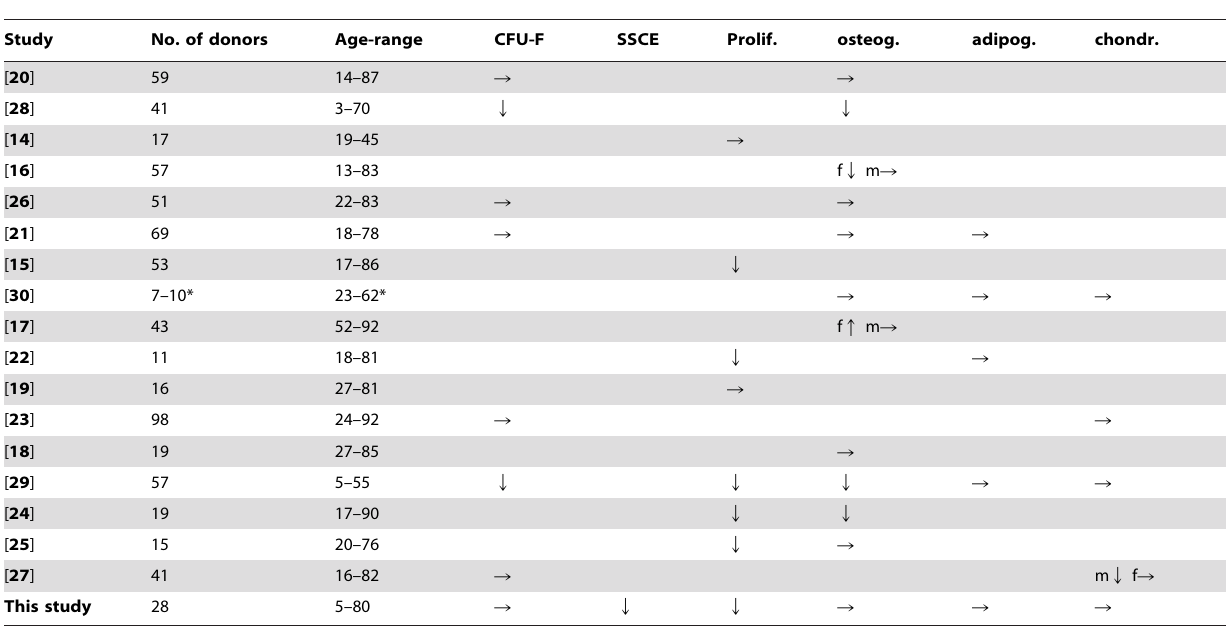
*No. of samples used for age correlation. R no effect, Q decrease with age, q increase with age. f=female, m=male.